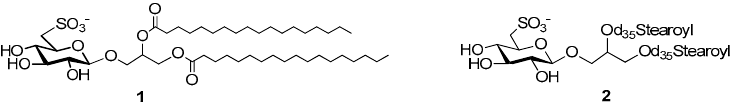
Figure 1. Chemical structure of Sulfavant A ( 1 ) deuterated Sulfavant A ( 2 ) .